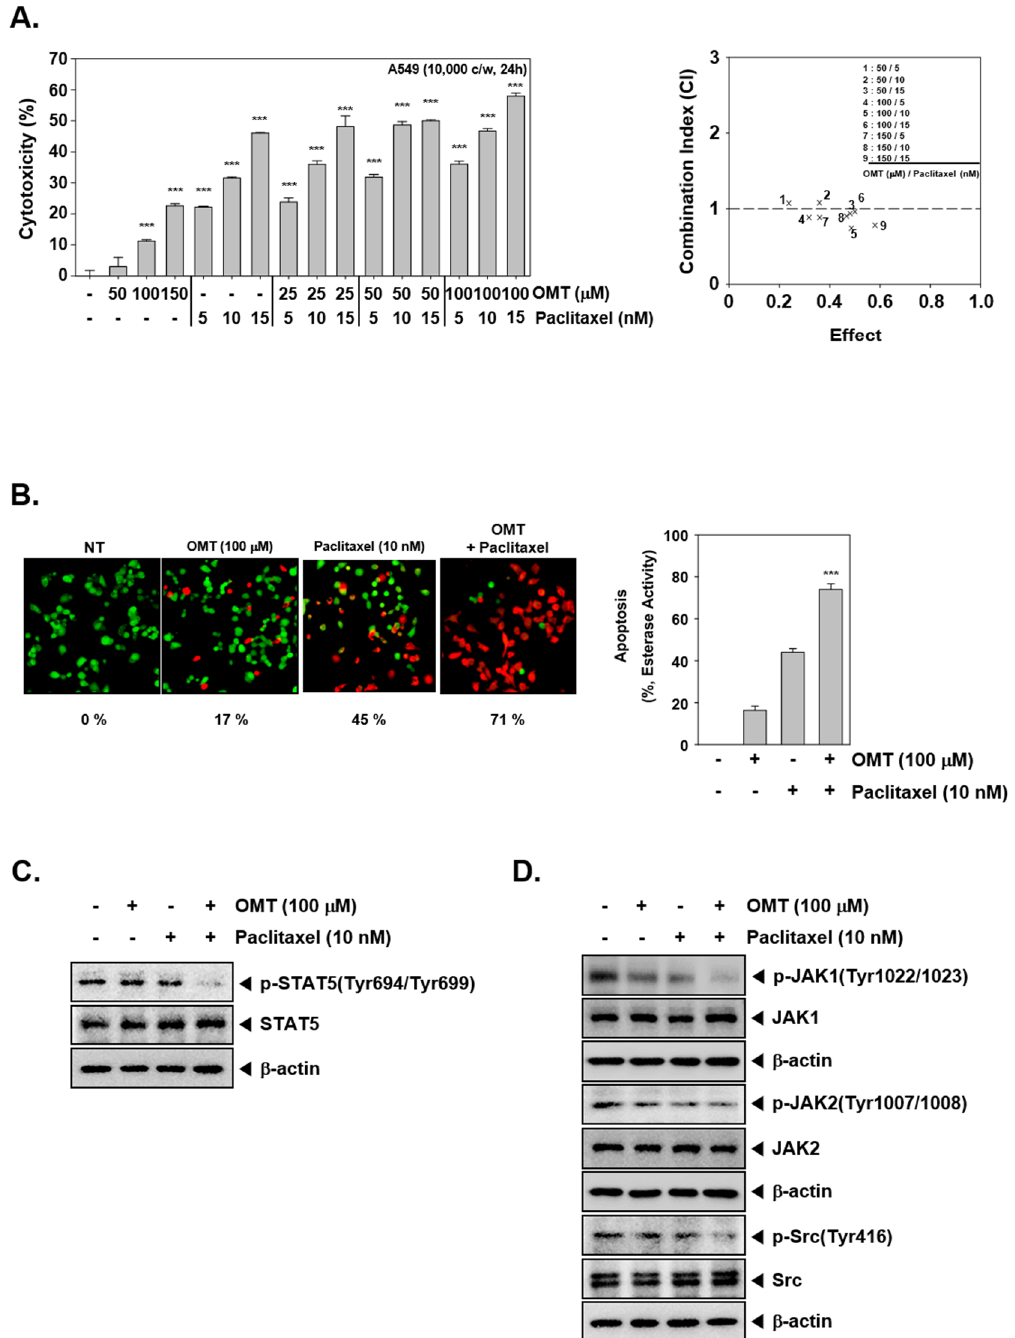
Figure 4. OMT and paclitaxel can enhance cytotoxicity in A549 cells. ( A ) Cytotoxicity of OMT and paclitaxel were analyzed by MTT assay. A549 cells (1 × 10 4 cells/well) were treated with OMT and paclitaxel in various concentrations for 24 h. The average of CI values about various combination indicates that the best combination ratio was that of 100 µ M OMT and 10 nM paclitaxel. ( B ) Cytotoxicity of OMT and paclitaxel were analyzed using a Live and Dead assay. A549 cells (2 × 10 4 cells/well) were treated with 100 µ M OMT and 10 nM paclitaxel for 24 h. Live cells were stained in green and dead cells were stained in red. The graph (right) shows the rate of dead cells by quantification. The results are presented as the mean ± SE. The experiments were performed three times independently. *** p < 0.001 compared to the control. ( C , D ) A549 cells (5 × 10 5 cells/well) were treated with 100 µ M OMT and 10 nM paclitaxel for 6 h. The Western blot experiments were carried out as shown above in Figures 1B,C.